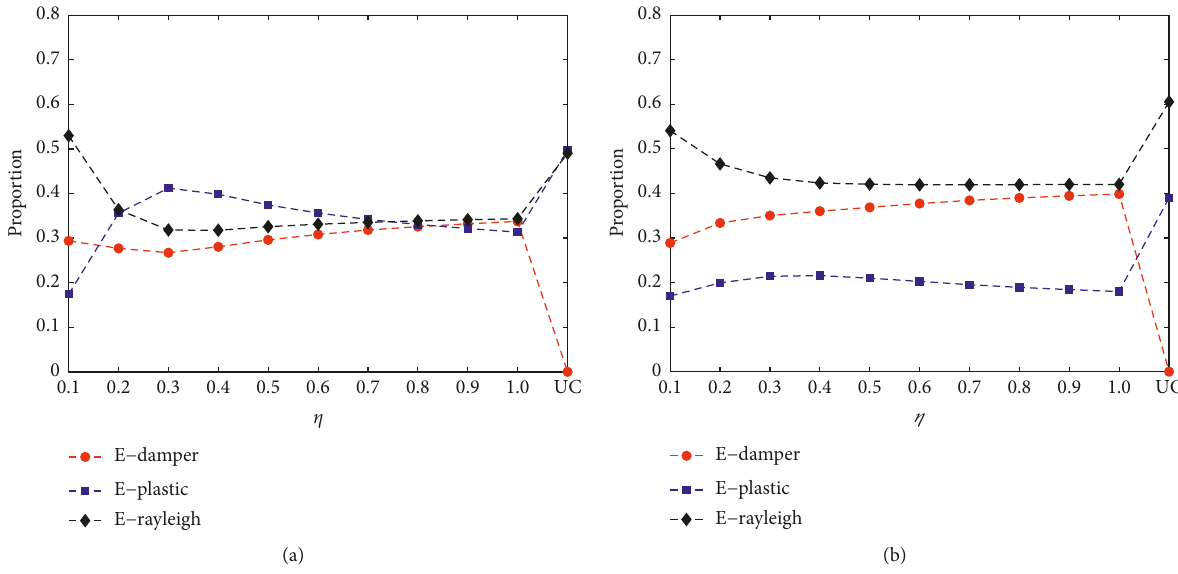
Figure 20: Proportional relationship between structural damping energy dissipation, plastic deformation energy dissipation, and damper energy dissipation (E-damper, E-plastic, and E-Rayleigh denote the energy dissipation ratio of the Reid dampers, structural plastic de- formation, and structural Rayleigh damping, respectively, η 0 . 1 ∼ 1 . 0 indicate the code names of the 10 schemes, respectively, and UC (cid:31) indicates the uncontrolled structure): (a) Hachinohe; (b) Northridge.